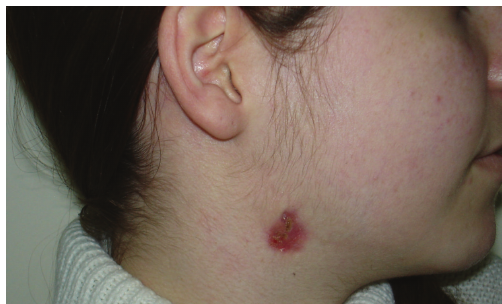
Figure 4: Fistula of the right lateral